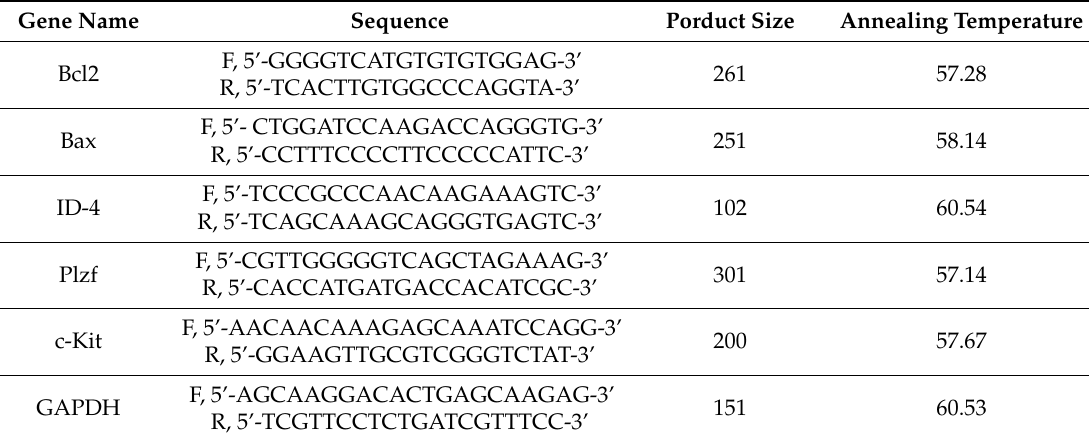
Table 1. Primers used in analyses of the e ff ects of T. ammi oil on spermatogonial